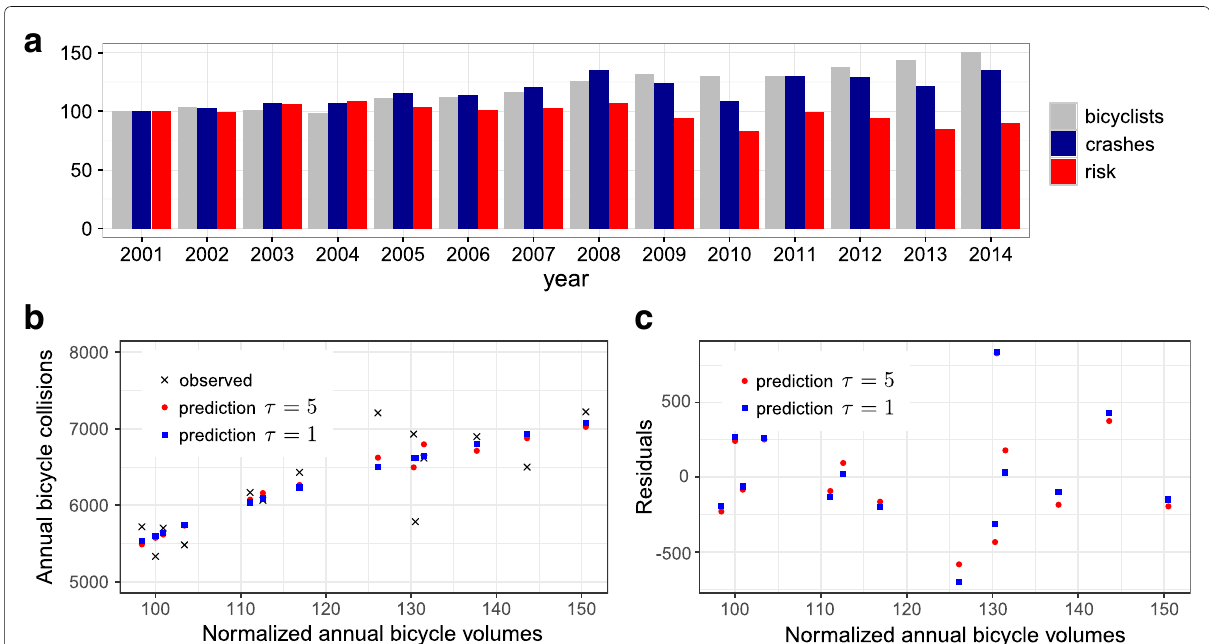
Fig. 5 a Development of normalized annual bicycle volumes (official estimate), crash numbers, and risk in Berlin (the reference for the normalization is the year 2001, where the number of accidents was 5332); b Normalized annual bike volumes versus the observed and predicted annual crash numbers. Predictions are obtained from a ML fit for (2) without memory, i.e., τ = 1, and with τ = 5 years memory, which yielded the maximal likelyhood among τ = 1, ... ,10; c Normalized annual bike volumes versus the residuals for the predictions shown in ( b )